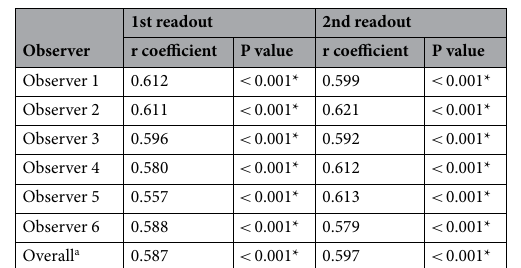
Table 3. Correlation between the readout grades and the quantified densitometric color in all of 6 observers and in the first and second readouts. * P < 0.05. a Values for the data set of 1254 total grades (209 images × 6 observers) at each readout.